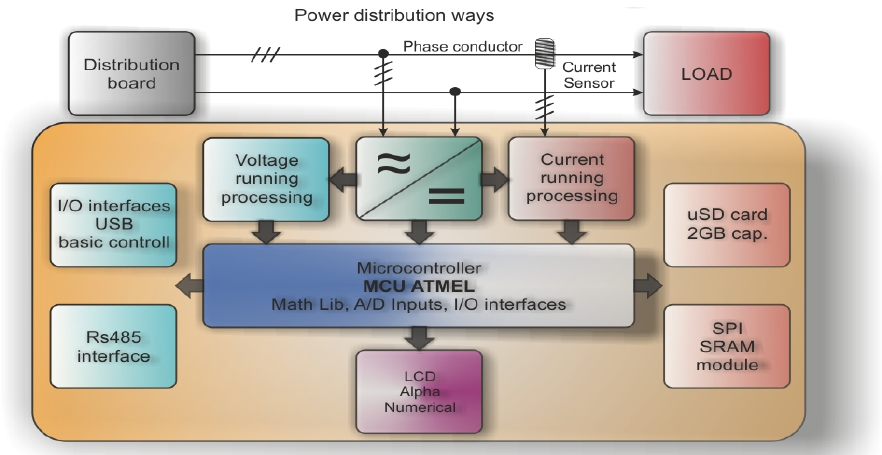
Figure 1. Analyzer block